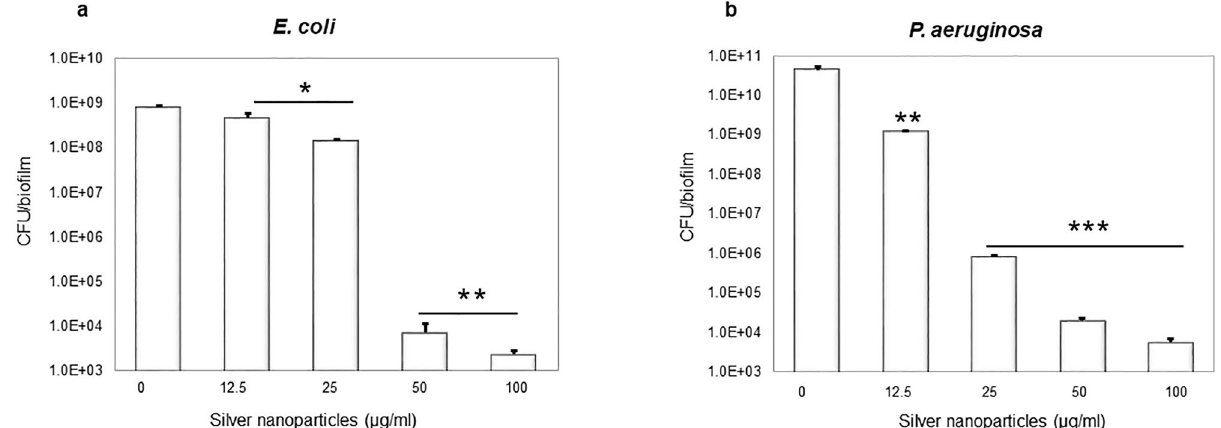
Figure 8. CFU count after treatment with AgNPs ( a ) E. coli and ( b ) P. aeruginosa . Data represent mean ± standard deviation error. *p < 0.05; **p < 0.005; ***p < 0.0001.